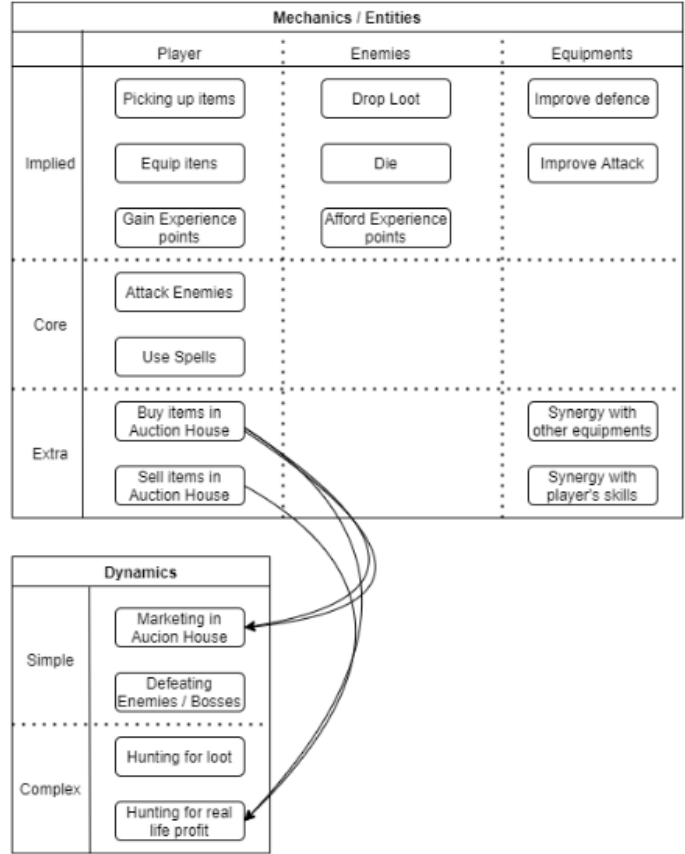
Figure 3. Diagram of the scenario translated to RMDA.